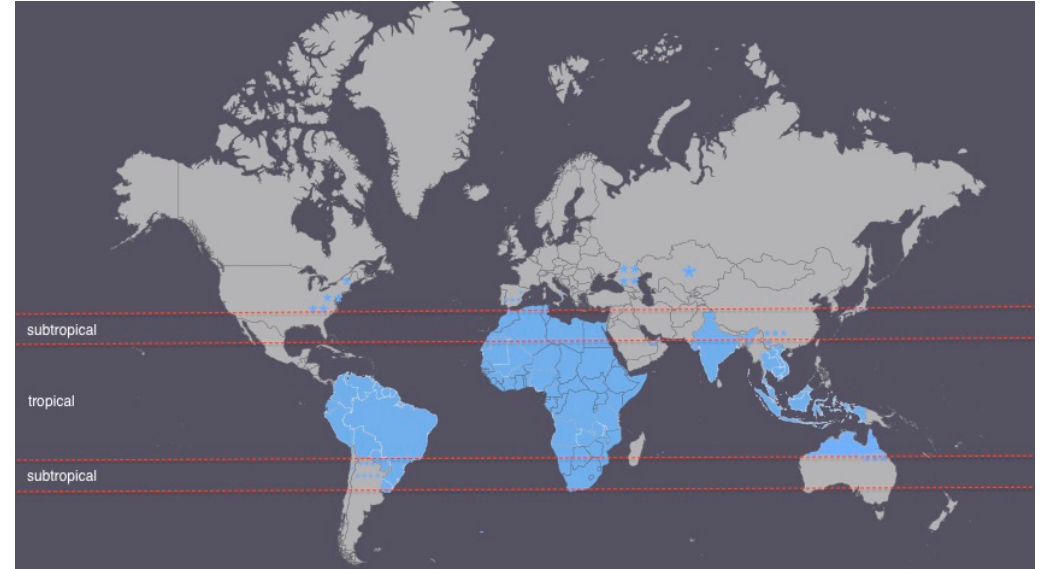
Figure 1. Countries with Strongyloides stercoralis cases (colored blue or marked as a “star” sign) on a world map divided into tropical and subtropical zones.